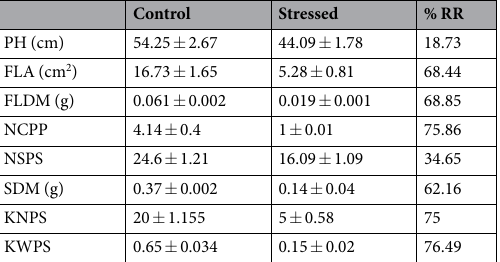
Table 1. Phenotypic analyses on plant groups (control and stressed) of durum wheat grown with different N concentrations. For each parameter, mean values ( ± standard error) and relative reductions between control and stressed conditions are presented. PH: plant height; FLA: flag leaf area; NCPP: number of culms per plant; NSPS: number of spikelets per spike; SDM: spike dry matter; FLDM: flag leaf dry matter; KNPS: kernel number per spike; KWPS: kernel weight per spike; RR: relative